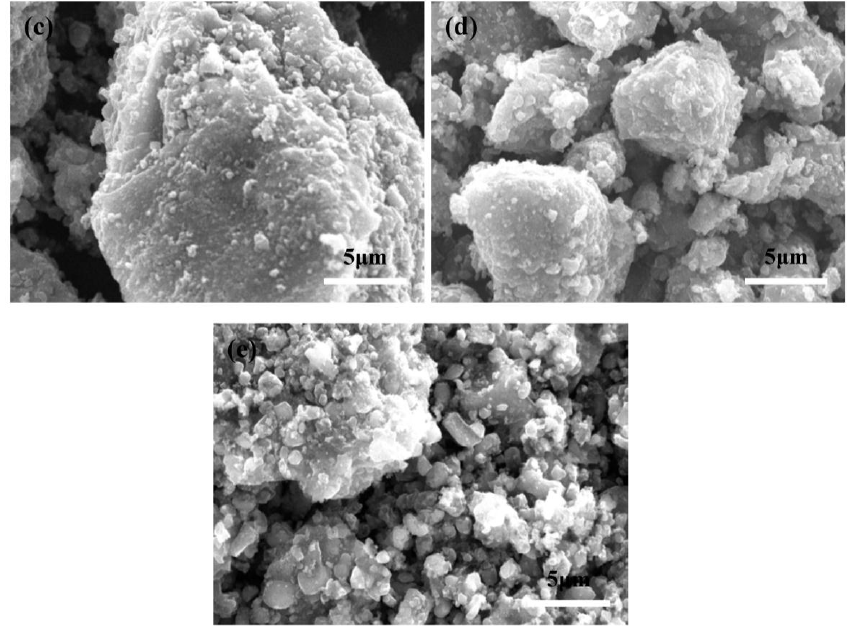
Figure 2. Scanning electron microscopy (SEM) images of the LVPBC and pristine LVPC composites. LVPBC-0.08 ( a ); LVPBC-0.14 ( b ); LVPBC-0.20 ( c ); LVPBC-0.26 ( d ); and LVPC ( e ).